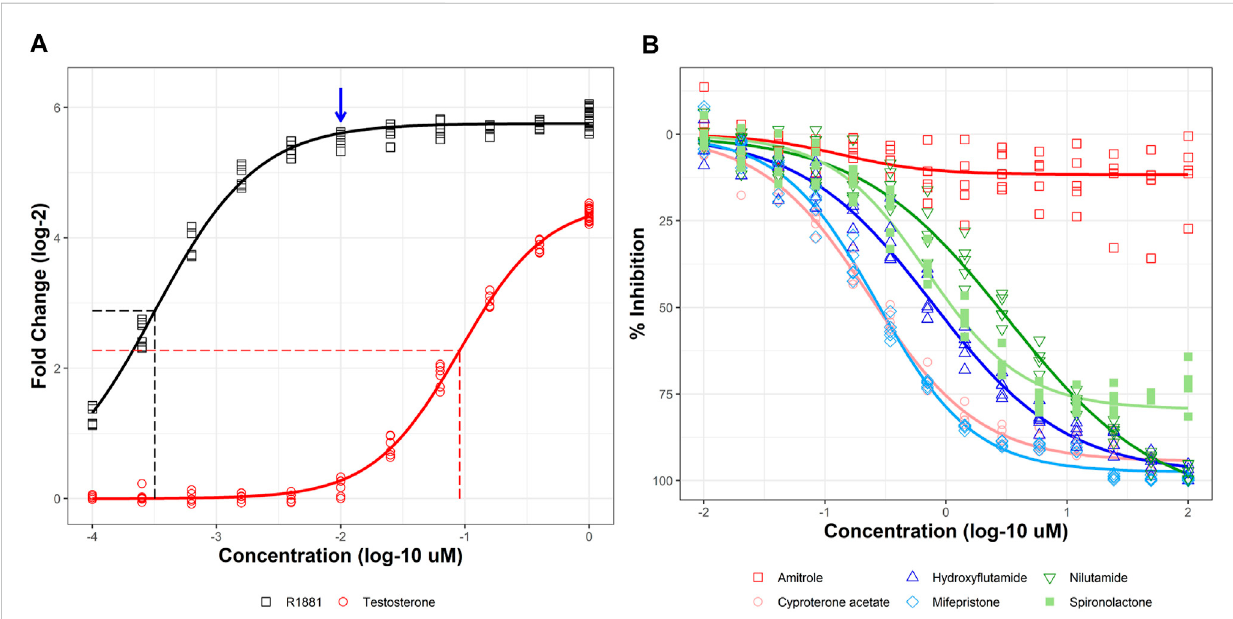
FIGURE 2 AgonistandantagonistresponsesinstableAR2assay.StableAR2cellsweretreatedwithagonistsatconcentrations rangingfrom100pMto1 µM (A) or co-treated with 10 nM R1881 and antagonists at concentrations ranging from 10 nM to 100 µM (B) for 18 h before NanoLuc luciferase activity detection. Micromolar concentrations are expressed as log 10 ( x -axis). Responses are expressed as fold change (log 2) over DMSO vehicle for agonists and % inhibition (maximal response) for antagonists. Concentration-response curves were fi t using tcpl_Lite. Horizontal dashed lines show half maximal response for agonists and vertical dashed lines mark the half maximal active concentration (AC 50 ). The blue arrow is shown to denote the >